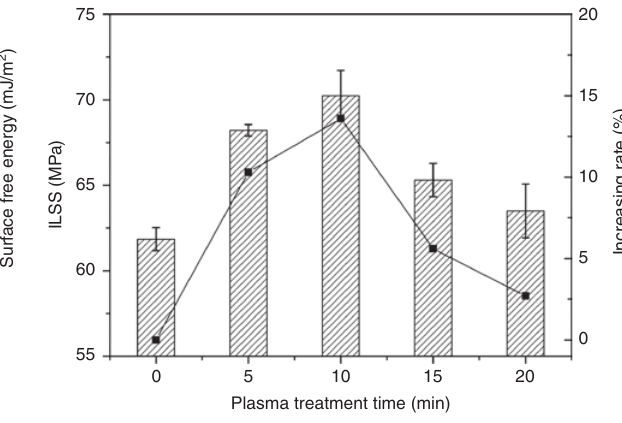
Figure 4: The contact angle and the surface free energy of the polyimide fibers. Figure 5: The ILSS of the PI/EP